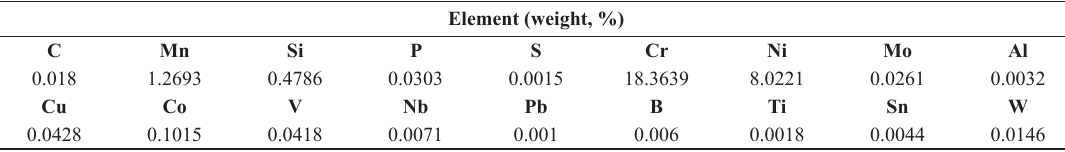
Table 1. Chemical composition of the material.